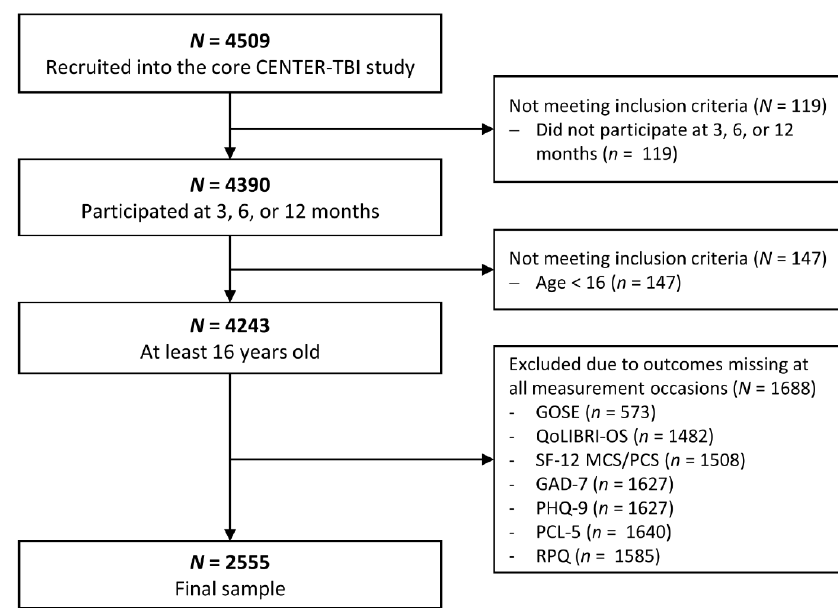
Figure 1. Flow chart of sample